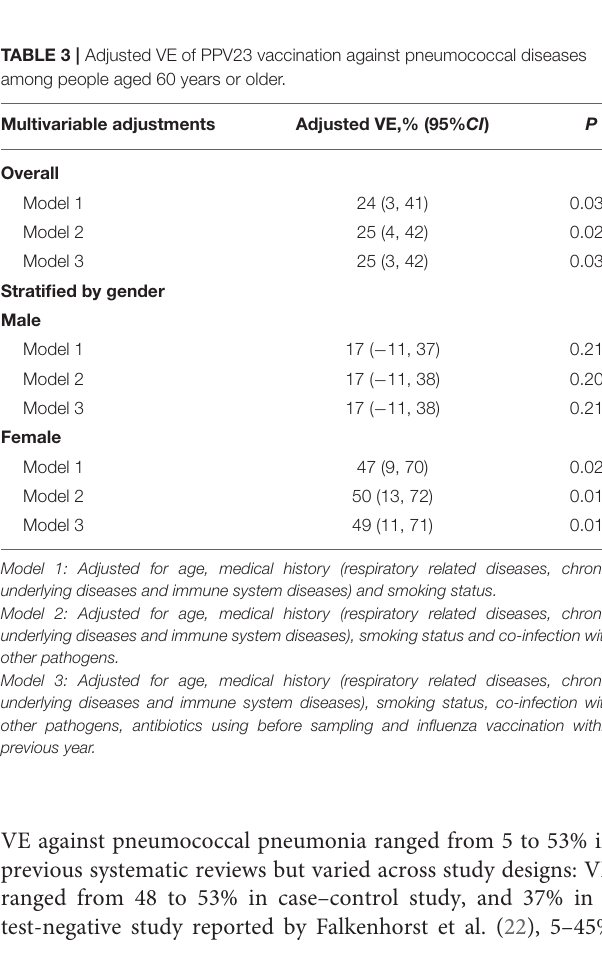
FIGURE 2 | Clinical presentation within cases and controls in the study of pneumococcal vaccine effectiveness in Shanghai.